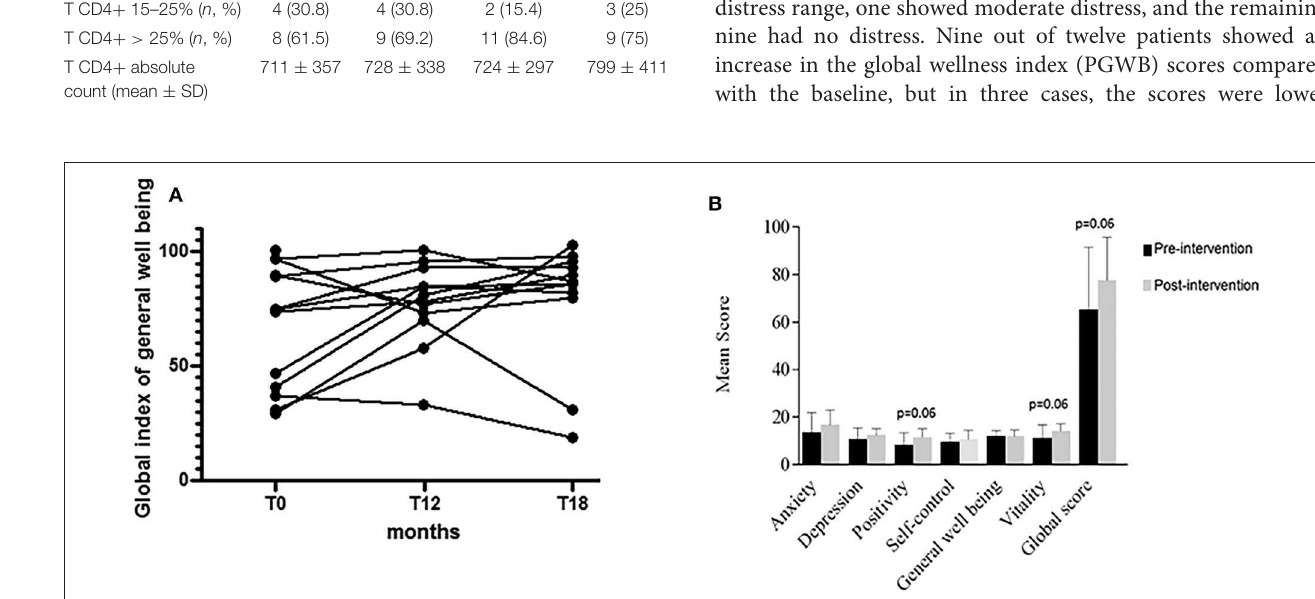
Frontiers in Pediatrics |